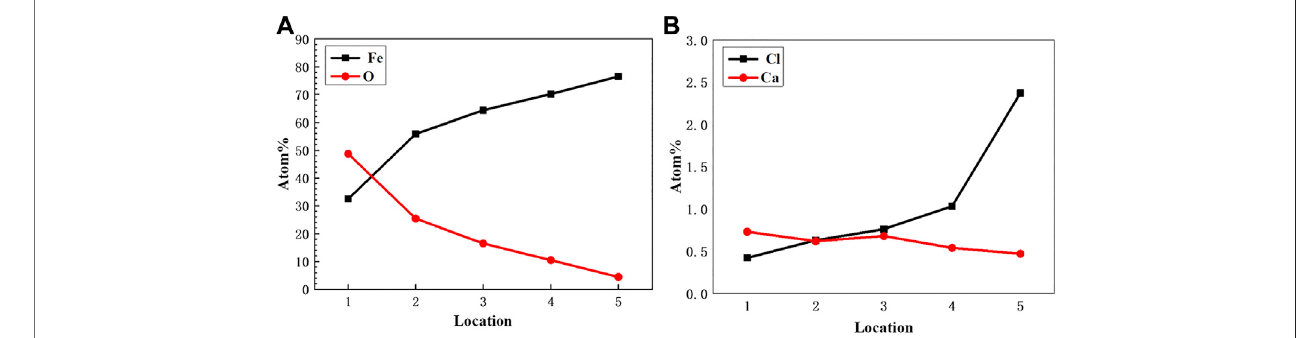
FIGURE 10 | EDS element analysis in Pitting.